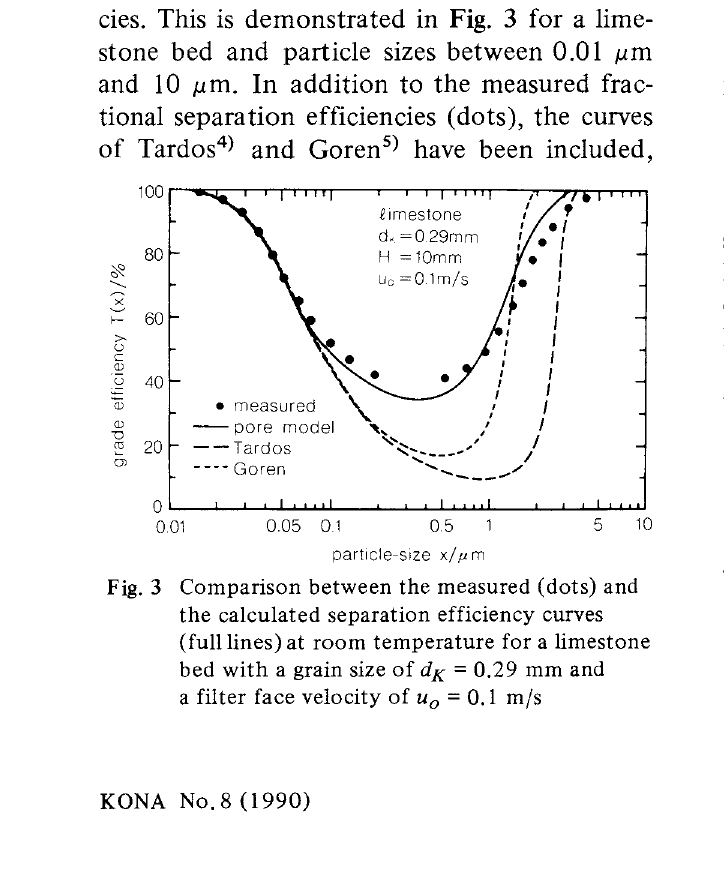
pellets caco,;so, Co= 1500ppm Uo = 025m/s d, = 1.9mm T = 600°C H = 2cm